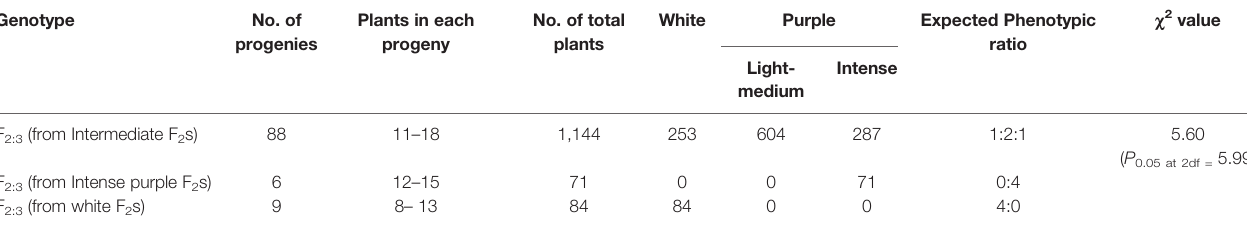
TABLE 2 | Segregation of F 2:3 progenies for curd color trait in white:intermediate:purple categories. Genotype